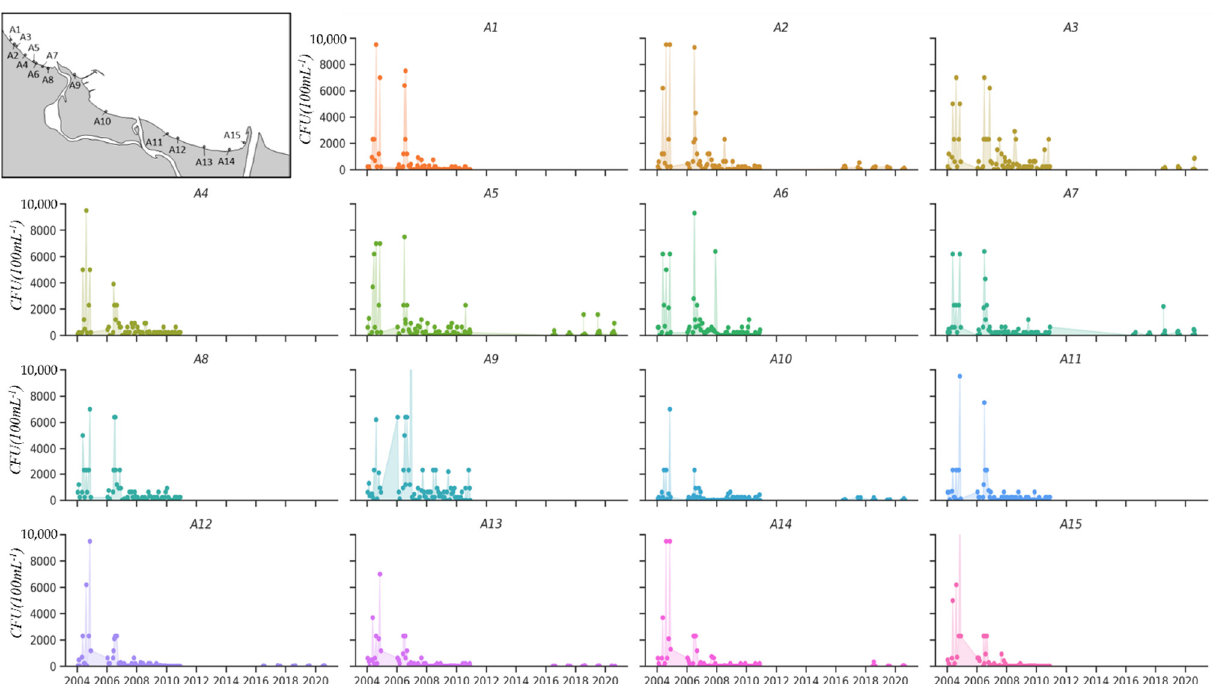
Figure 5. The average concentration of E. coli (CFU·100 mL − 1 ) in bathing water of Gda ń sk Bay for the period 2004–2020.